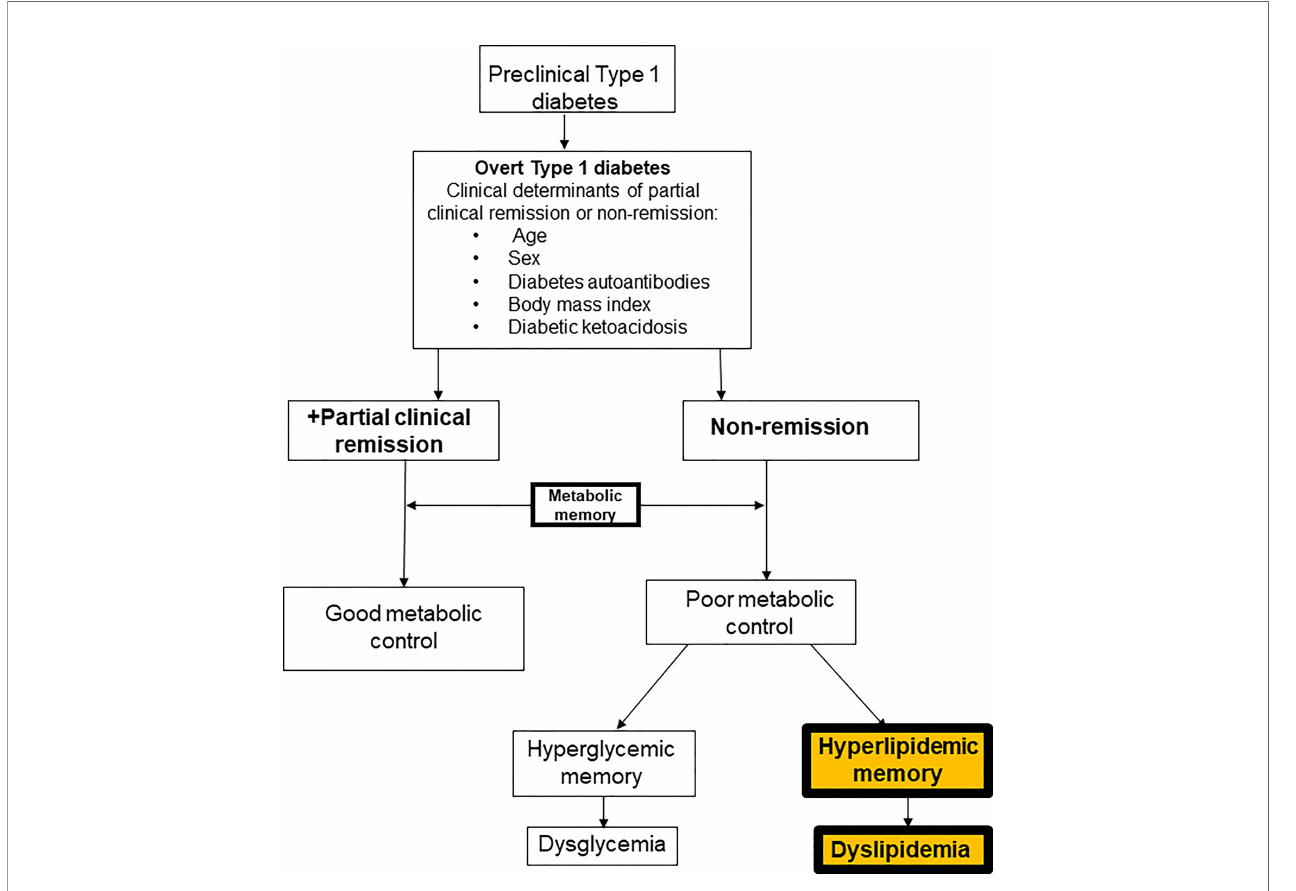
FIGURE 1 | A composite scheme of the dichotomy of subjects with type 1 diabetes based on the history of partial clinical remission into remitters and non-remitters and the role of metabolic memory on long-term metabolic parameters. The theory of hyperglycemic memory explains the dysglycemia in non-remitters while the theory of hyperlipidemic memory explains the dyslipidemia in